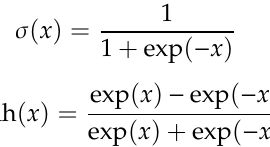
Figure 1. Illustration of the gated recurrent unit memory cell. h t − 1 is the output of the previous hidden layer node, x t is input of the current hidden layer node, h t is the output of the current hidden layer node, z t and r t are the output of the update gate and the reset gate, respectively.